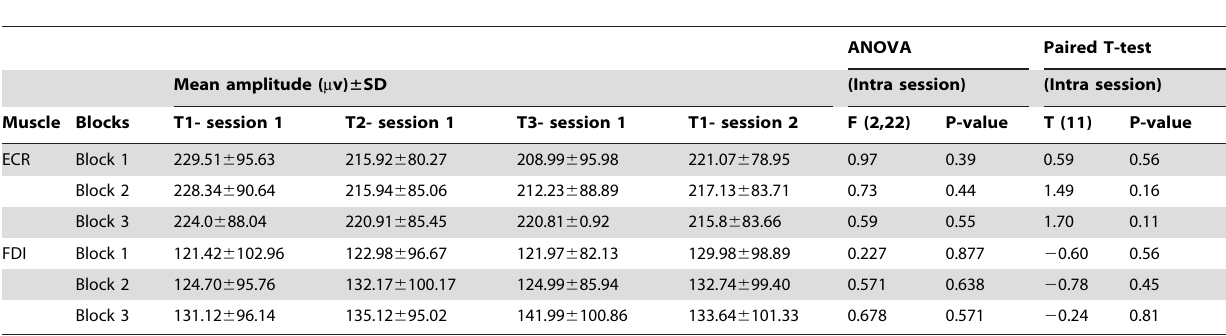
Table 1. Mean, standard deviation and level of agreement of MEPs amplitude for three blocks of trials recorded from ECR and FDI muscles.